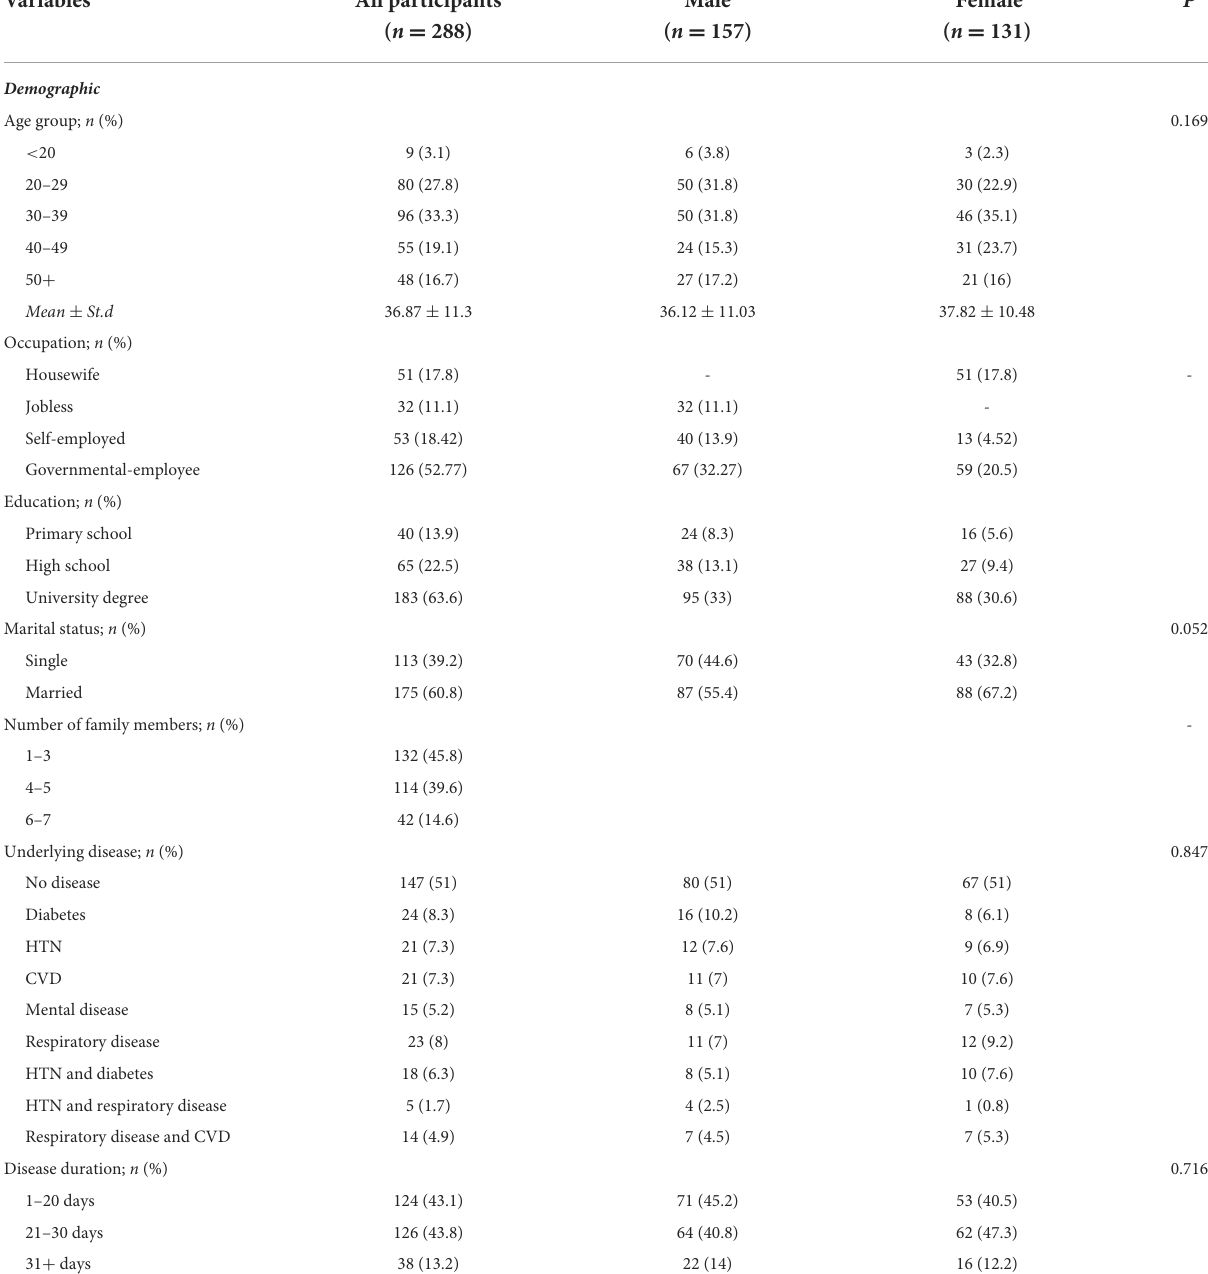
TABLE 1 Demographic and clinical characteristics of COVID-19 patients with the home-quarantined condition.